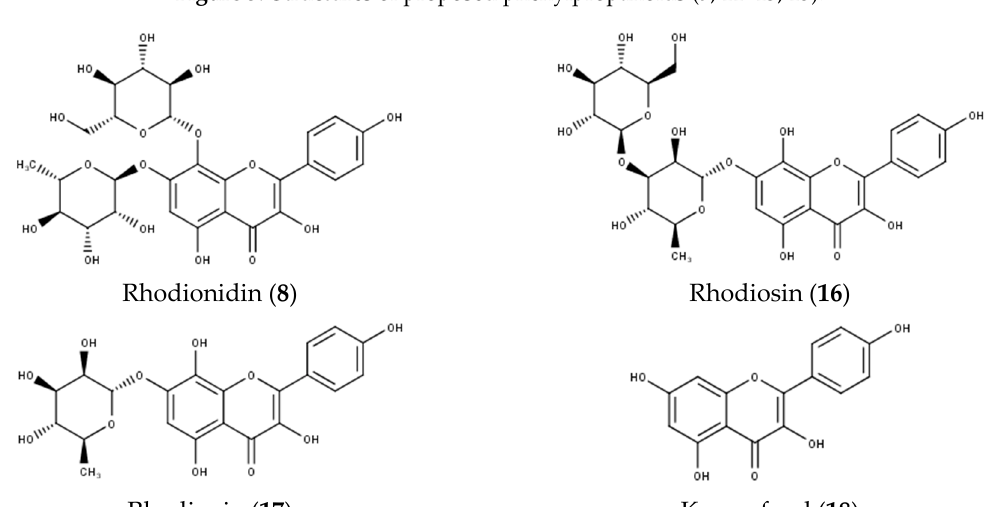
Figure 4. Structures of proposed flavonoids ( 8 , 16 – 18 )